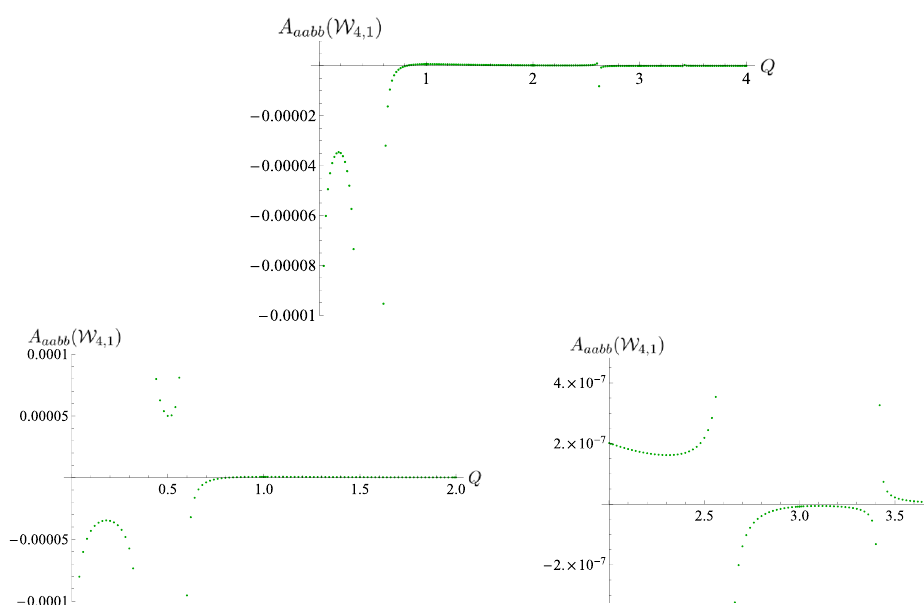
Figure 15 . The bootstrap result of the amplitude A aabb ( W 4 , 1 ) and its detailed pole structures in the regions 0 < Q < 2 and 2 < Q < 4